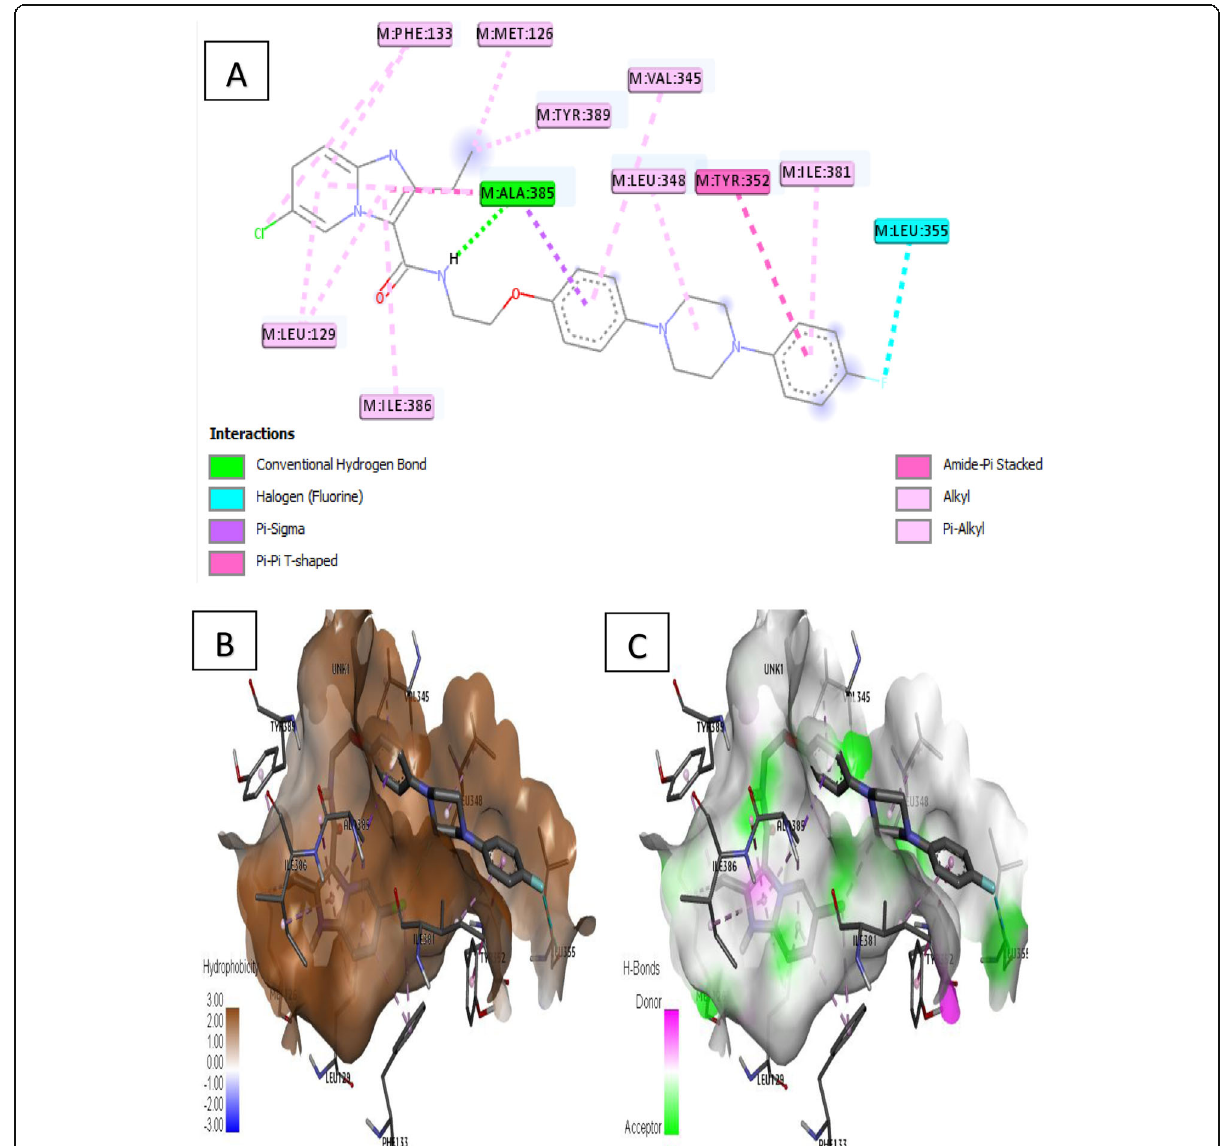
Fig. 10 Docking interaction of complex 35. a 2D docked view of complex 35. b Hydrophobicity surfaces of complex 35. c Hydrogen bond surfaces of complex